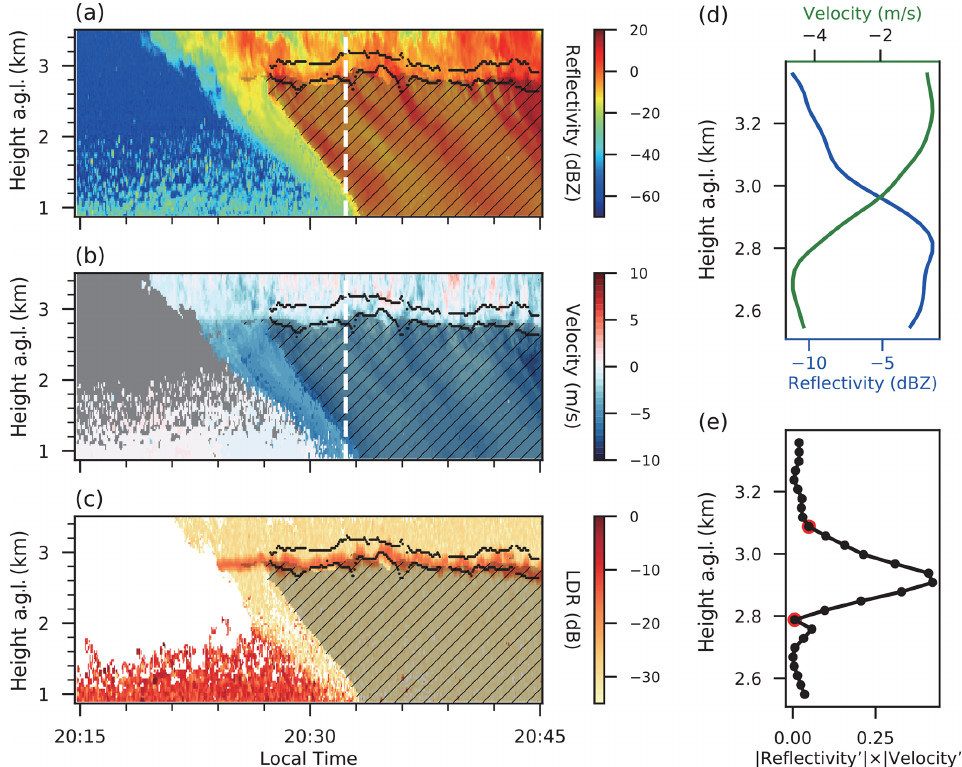
Figure 4. (a) Reflectivity, (b) velocity, and (c) LDR from 20:15 to 20:45LT on 10 August 2013. (d) Reflectivity and velocity, and (e) | reflectivity (cid:48) |×| velocity (cid:48) | profile of the dashed white line in panels (a–b) . Black dots and the slashed shading area in panels (a–c) are the identified melting layer and precipitation. Red dots in panel (e) are the identified bottom and top of the melting